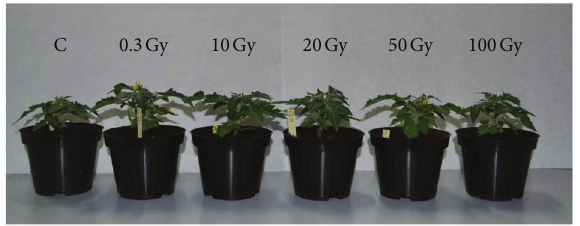
Figure 1: Plants of S. lycopersicum L. “Microtom” developed from control and irradiated seeds at 40 DAS (Days After Sowing). Plants from seeds exposed to increasing doses of X-rays (from 0 to 100Gy) are shown from left to